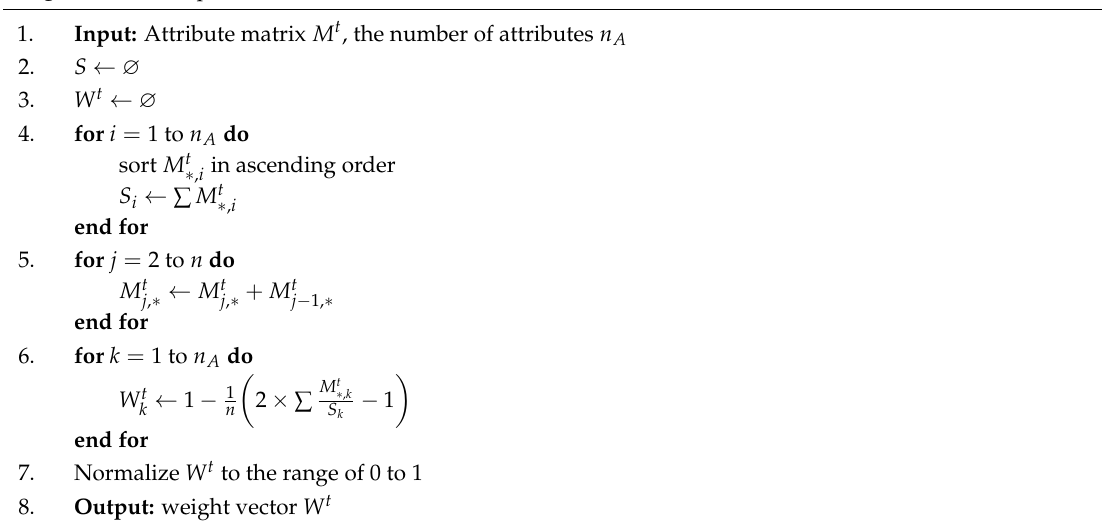
Algorithm 1: Temporal attribute fusion based on